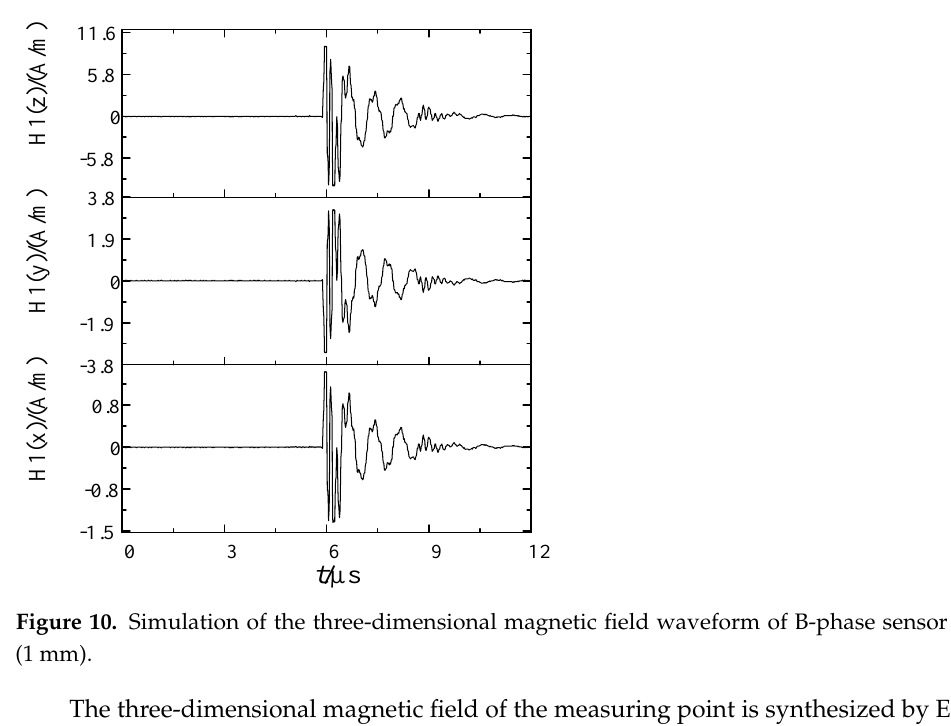
Figure 12. Power spectrum of simulated magnetic field intensity (1 mm). According to the scale positioning of the peak wave head in Figure 12, the character- istic frequencies were about 1.33 MHz, 21 MHz, 31 MHz, etc., and the energy was high at the characteristic frequency. The high-frequency component decayed quickly, the dura- tion was short, the PSD value at the characteristic frequency was small, and the energy was weak. Figures 13 and 14 shows the PSD of the 2 mm and 3 mm ball gap, which had similar spectral characteristics. Figure 13. Power spectrum of simulated magnetic field intensity (2 mm).